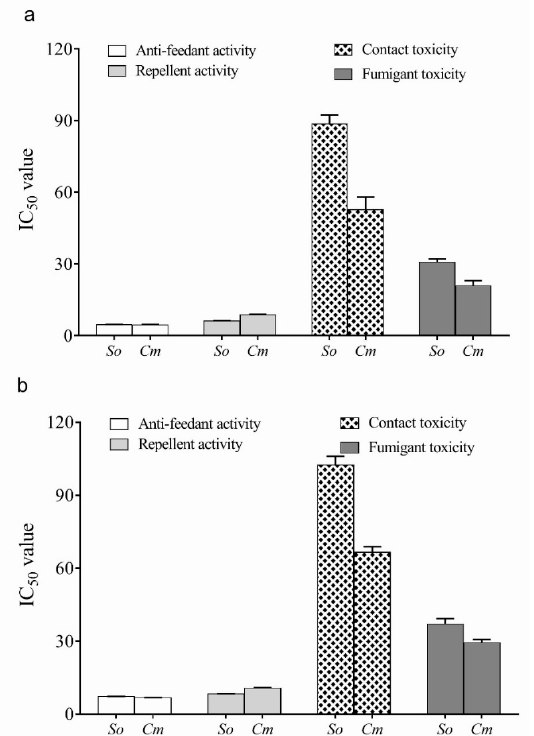
Figure 1. Insect repellent and insecticidal properties of the Cinnamomum verum flower (FEO) ( a ) and leaf (LEO) ( b ) essential oils against the pests of stored grains Sitophilus oryzae (So) and Callosobruchus maculatus (Cm). The values shown on the Y-axis is the IC 50 or half-maximal inhibition concentrations for respective biological activities compared to the untreated control group. A similar trend was also observed against C. maculatus ; the half-maximum inhibition concentration for antifeedant activity, repellency, fumigant, and contact toxicity were found to be 4.52 ± 0.17, 8.80 ± 0.18, 52.81 ± 5.11, and 20.97 ± 2.05 μ g/L, respectively.